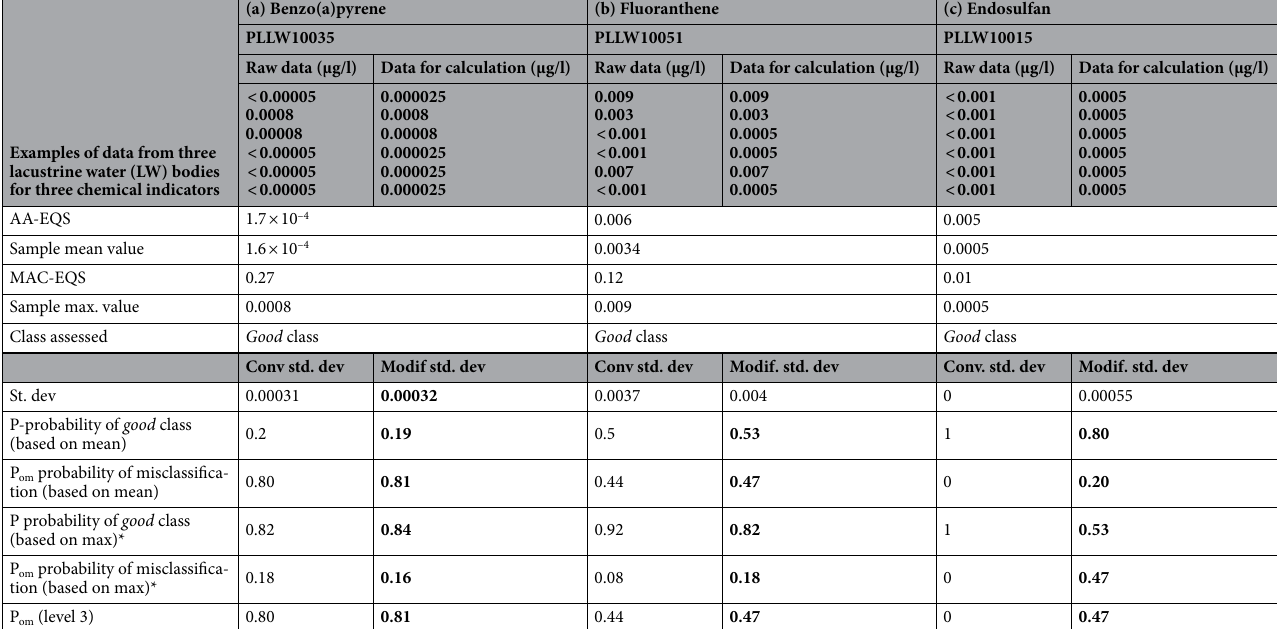
Table 2. Comparison of results of the probability of misclassification evaluation for chemical indicators with the application of conventional standard deviation with the suggested modified formula for calculating standard deviation for measurements including censored values. Values calculated by means of the modified formula are in bold. *P probability of good class, *P om probability of misclassification i.e. probability of below good